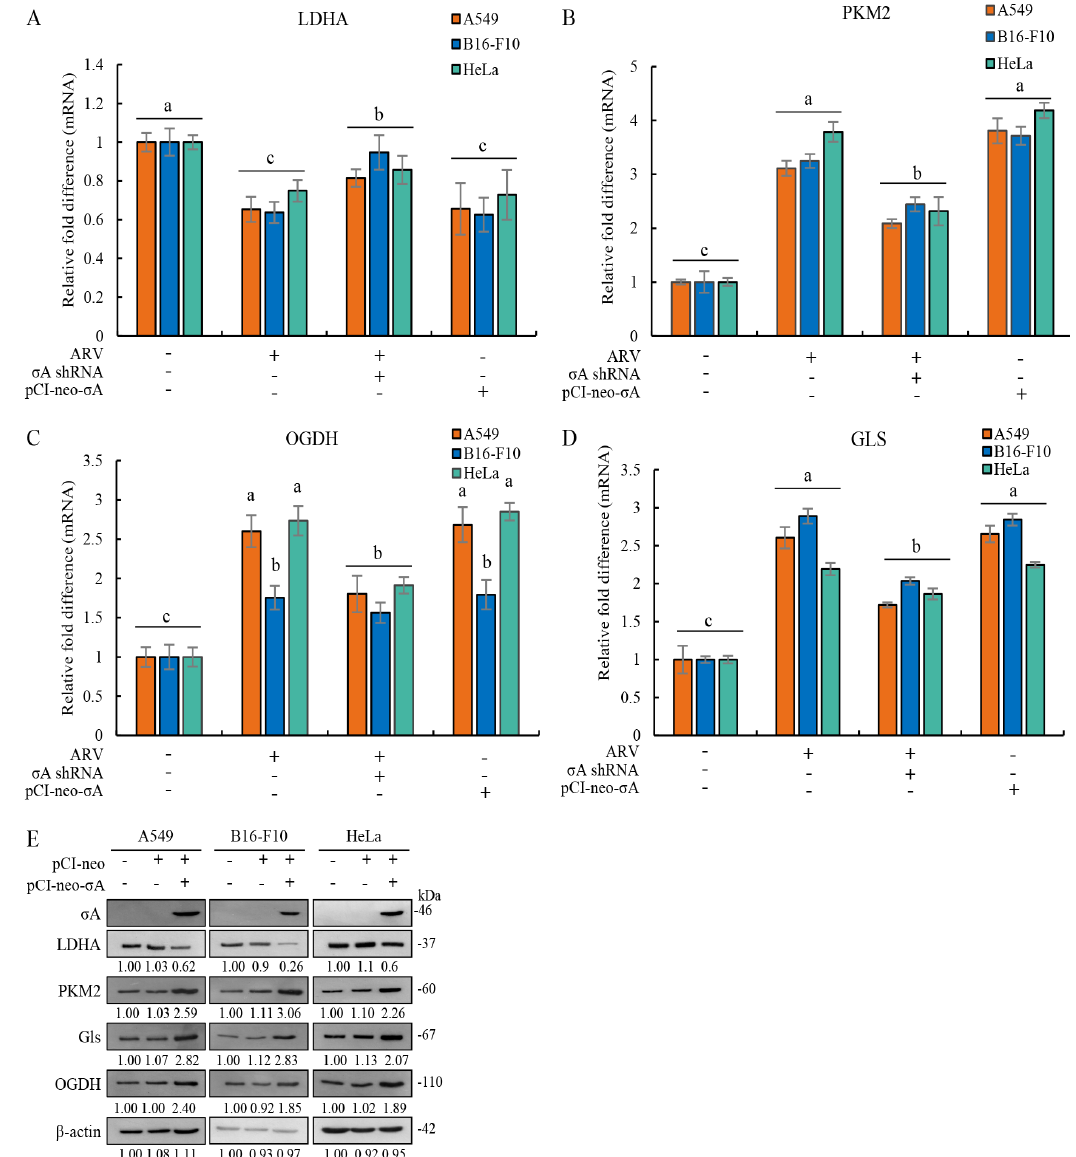
Figure 7. ARV infection and ARV σ A transfection alter levels of LDHA, PKM2, OGDH, and Gls in A549, B16-F10, and HeLa cancer cell lines. ( A – D ) The cancer cell lines were transfected with or without the pCI-neo- σ A or σ A shRNA vectors for 6 h followed infection with ARV at an MOI of 10 for collected for examining